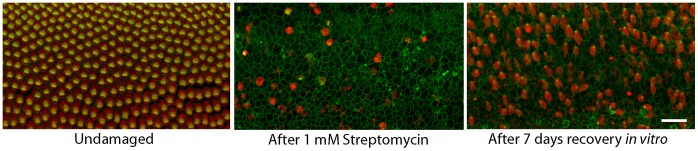
Ototoxic injury and hair cell regeneration in organotypic culture. Cultures of chick cochleae were treated for 24 hr with 1 mM streptomycin, which killed nearly all hair cells in the sensory epithelium (center). When such lesioned specimens were maintained for an additional seven days in streptomycin-free medium, significant hair cell recovery was observed (right). All images show the midregion of the chick cochlea. Labels: red-Myosin VIIA (hair cells), green-phalloidin. Scale bar = 30 µm.